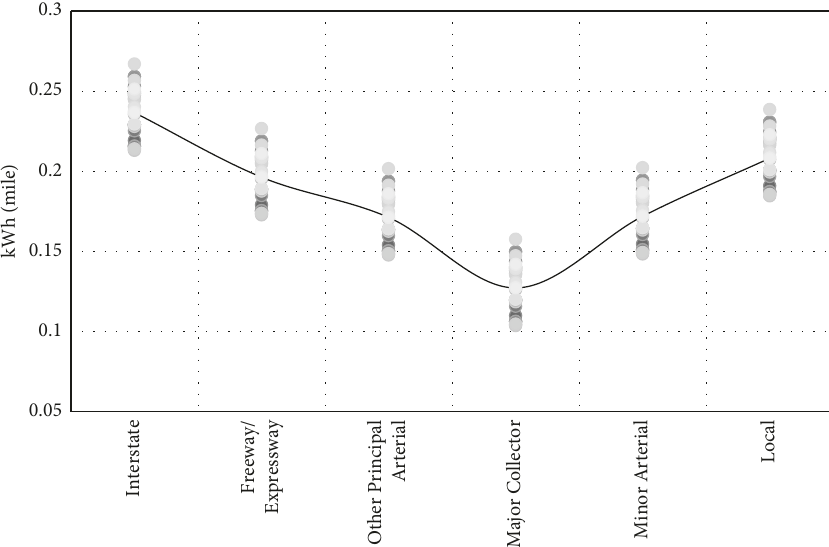
Figure 5: Fitted values for drivers and different road types. Table 10: Energy consumption comparison